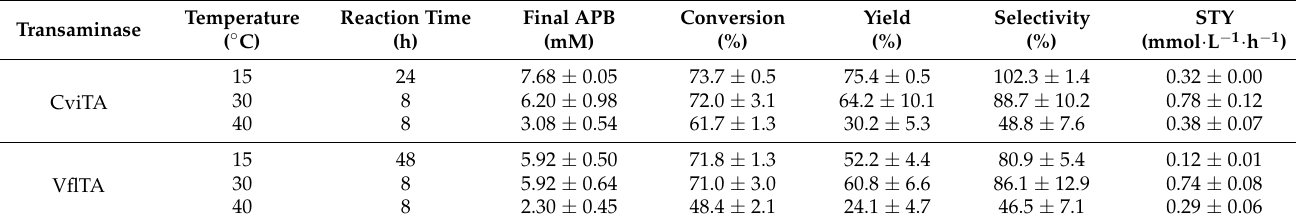
Figure 5. Temperature effect on 3-APB synthesis and operational enzymatic stability. ( A ) Reaction time courses performed with CviTA-PDC and ( C ) VflTA-PDC at 15 ◦ C ( (cid:78) ), 30 ◦ C ( • ), and 40 ◦ C ( (cid:125) ). ( B ) Operational stability of Cvi-TA and ( D ) Vfl-TA at 15 ◦ C ( (cid:7) ), 30 ◦ C ( (cid:4) ), and 40 ◦ C ( ). Reaction conditions: pH 7.5; 4-PB 10 mM; L-Alanine 200 mM; TA 5% v · v − 1 ; PDC 25% v · v − 1 , 1 mM pyridoxal- 5’-phosphate (PLP), 0.1 mM thiamine pyrophosphate (TPP), and 0.1 mM MgCl 2 . Concentration values are reported in Tables S5–S10. Table 3. Process metrics of 3-APB synthesis applying the multi-enzymatic system TA-PDC at different temperatures. Reaction conditions: pH 7.5; 4-PB 10 mM; L-Alanine 200 mM; TA 5% v · v − 1 ; PDC 25% v · v − 1 , 1 mM pyridoxal-5’-phosphate (PLP), 0.1 mM thiamine pyrophosphate (TPP), and 0.1 mM MgCl 2